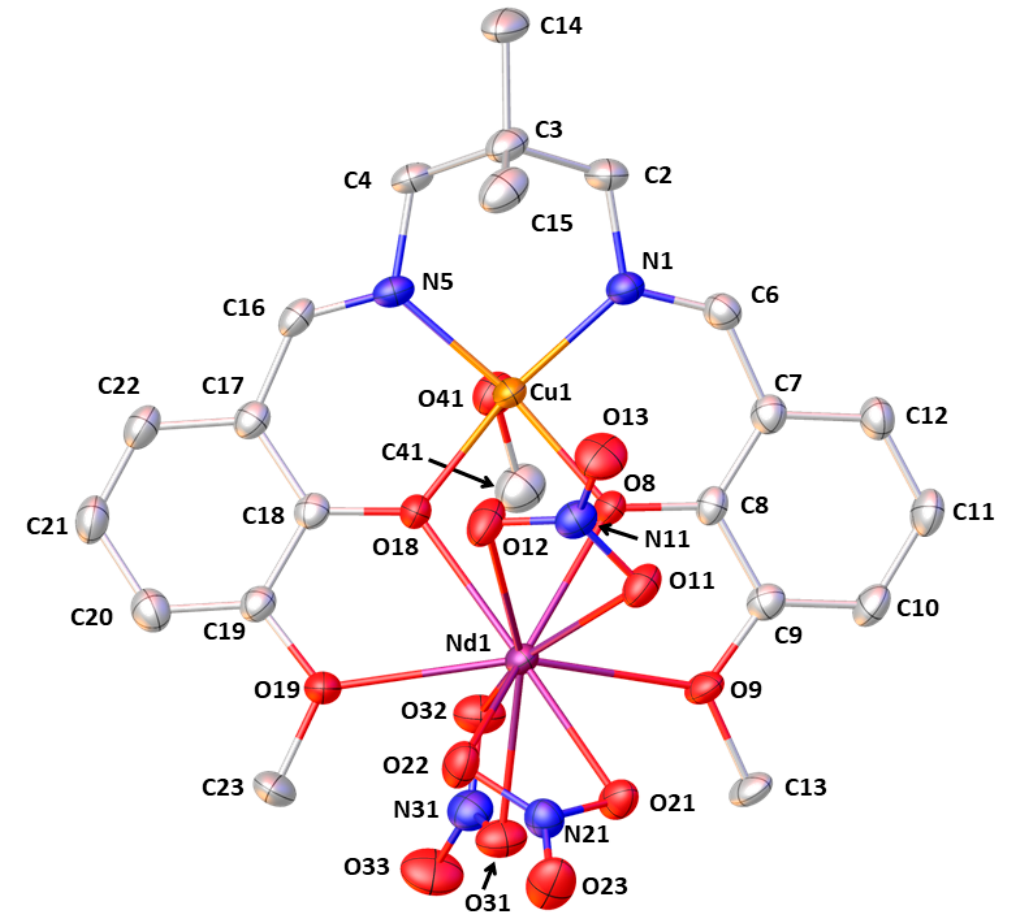
Figure 1. Molecular structure of 1-Nd . Hydrogen atoms are omitted for clarity. Anisotropic dis- placement ellipsoids are set at the 50% probability level. Images of 1-Ce and 1-Pr can be seen in Figure S26.